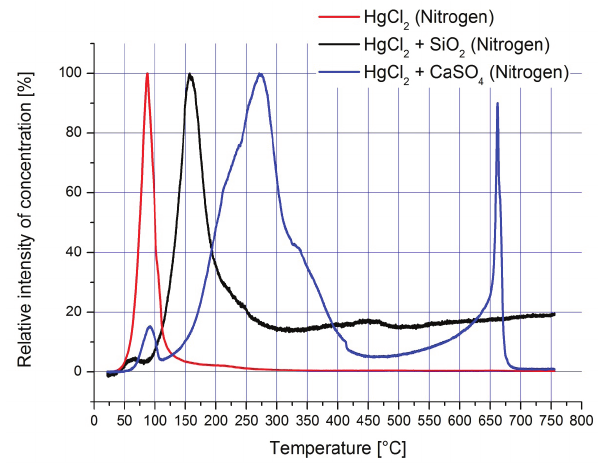
Cl mixtures, obtained by MS. 2 2